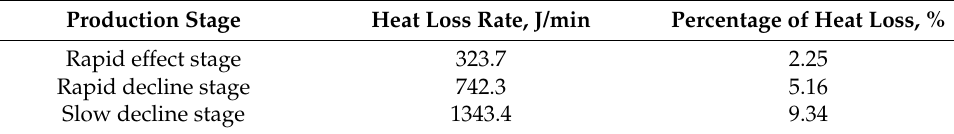
Table 5. Heat loss at different production stages in multi-thermal fluid